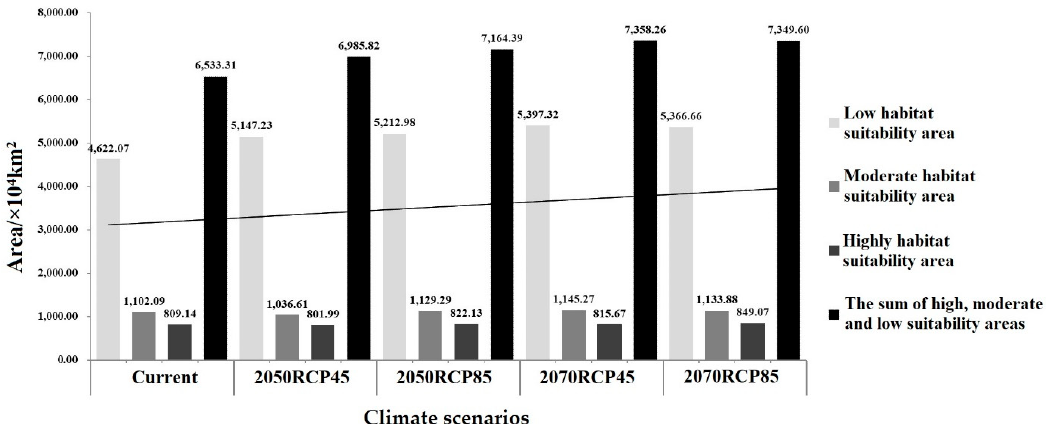
Figure 6. MaxEnt models predicting suitability areas of Icerya aegyptiaca on global scale under different climate scenarios.